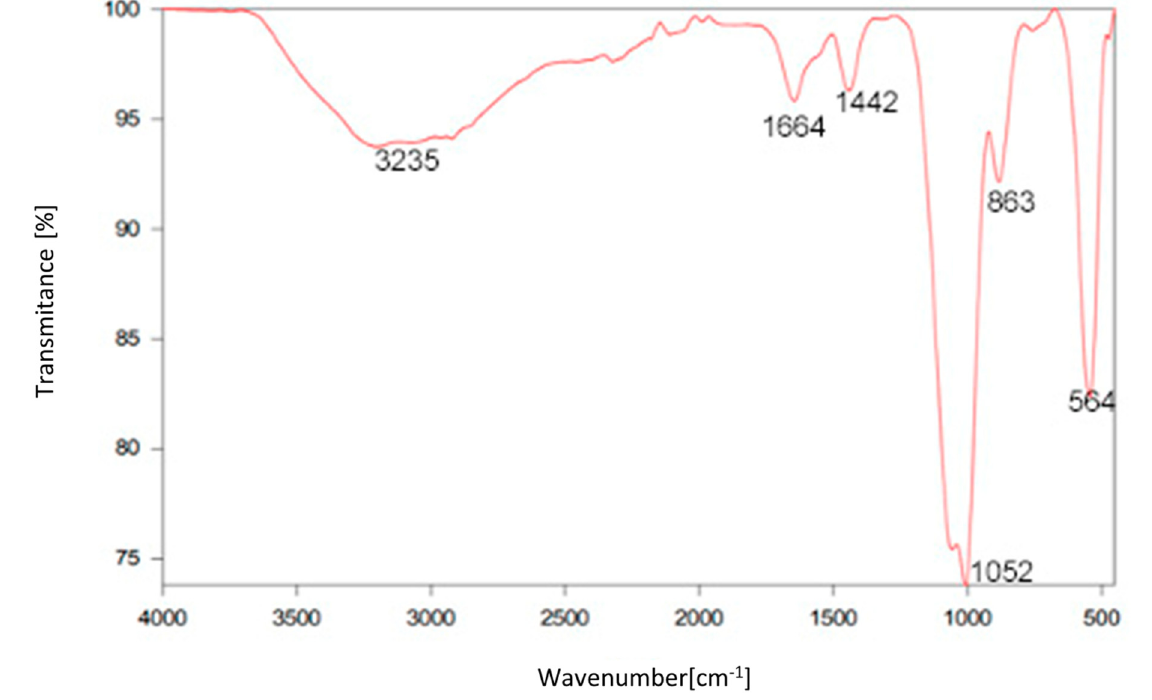
Figure 4. ATR-FTIR spectra for compositional characterisation of EPS t .